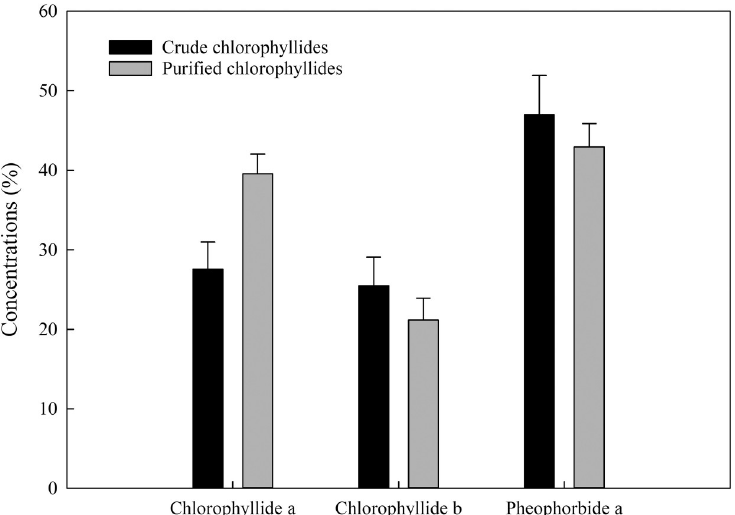
Fig 2. Comparison of major compounds from crude chlorophyllides and purified chlorophyllides. Data representing mean ± SE were obtained from three and five independent replicates of crude chlorophyllides and purified chlorophyllides, respectively. Further statistical analysis was performed by one way ANOVA using SigmaPlot Version 14.0. The statistical result indicated that there is not a statistically significant difference.